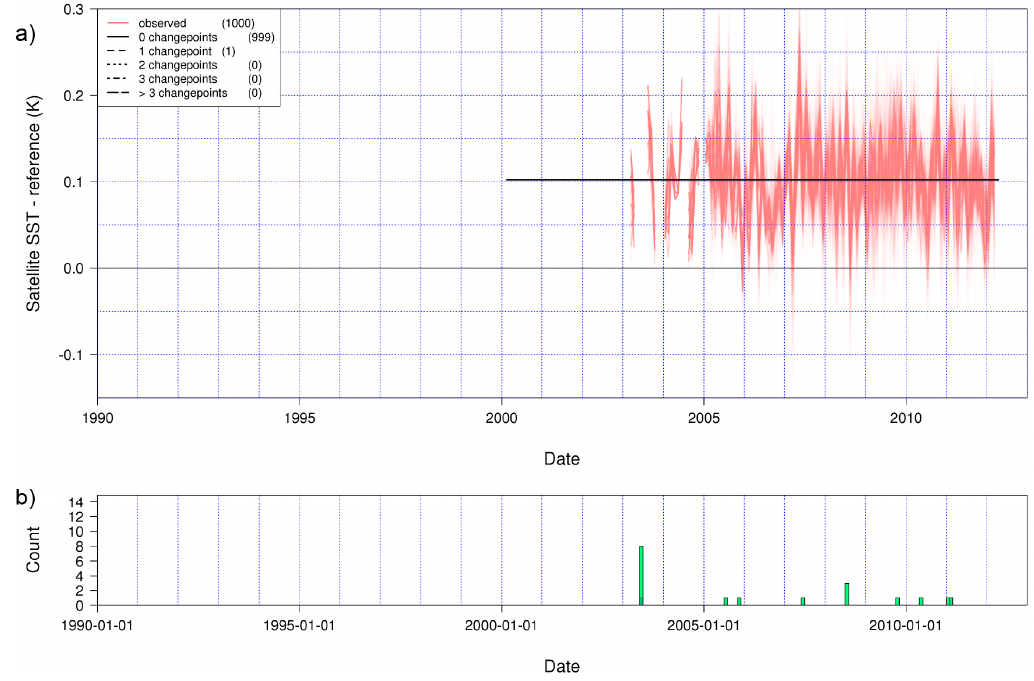
Figure 8. Scatter plot of the identified change point dates and step sizes for the drifting buoy analysis split into four groups. Panel ( a ) shows the steps identified over the full record—black represents break 1, red break 2, green break 3, and blue break 4. Panels ( b – e ) show scatter plots and histograms for the individual groups, the red dashed lines indicate the 2.5%, 50%, and 97.5% quantiles.